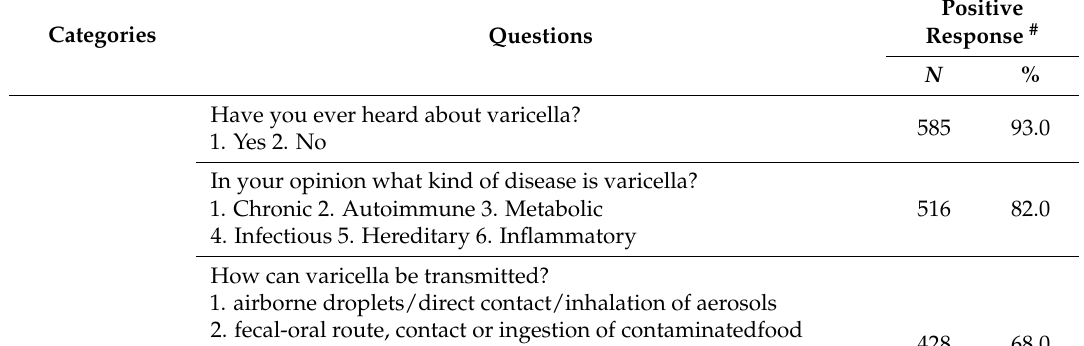
Table 2. Knowledge, attitude and practice on varicella and its vaccination of the participants in this study ( N =